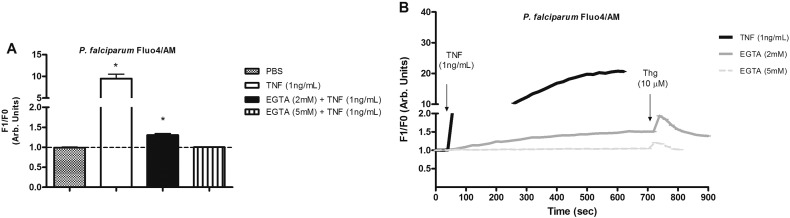
Extracellular calcium is required for TNF signalling in isolated P. falciparum labelled with Fluo4/AM (5 μM). (A) Analyses of Ca2 + concentration after addition of TNF (1 ng/ml) (9.746 a.u. ± 1.03, n = 15) or incubation with the extracellular calcium chelator EGTA (5 mM) for 1 min followed by addition of TNF (1 ng/ml) (1.002 a.u. ± 0.005, n = 11, P = 0.371), EGTA (2 mM) (1.304 a.u. ± 0.038, n = 9, P = 0.001) or PBS treatment (0.989 a.u. ± 0.016, n = 3). Bar graph means and SEM of at least three independent experiments. Arb. arbitrary. (B) Representative tracing of Fluo4/AM changes over time by addition of TNF (1 ng/ml) or TNF (1 ng/ml) followed by thapsigargin (10 μM) after incubation with EGTA (2 and 5 mM, respectively).